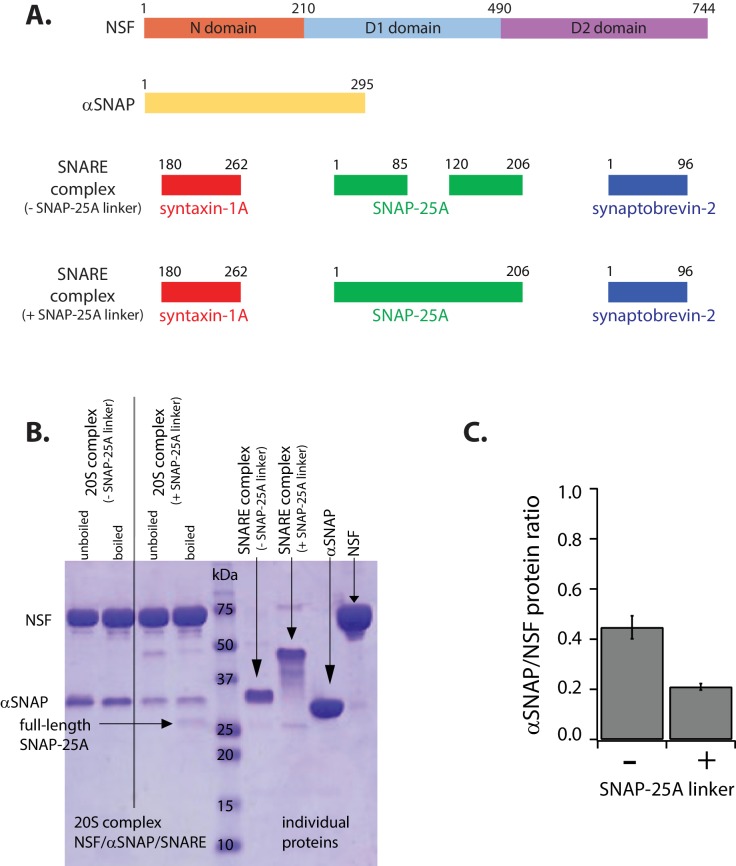
Protein quantification of the 20S complex using a gel-based assay.(A) Domain diagram of the 20S complex consisting of NSF (orange, light blue, pink), αSNAP (yellow), and the SNARE complex composed of the cytoplasmic domain of syntaxin-1A (red, amino acid range 180–262), two SNARE domains of SNAP-25A (green, amino acid range 1–85 and 120–206) or full-length SNAP-25A (green, amino acid range 1–206), and the cytoplasmic domain of synaptobrevin-2 (blue, amino acid range 1–96) (Materials and methods). (B) SDS-PAGE gel of the 20S complex formed in the absence and presence of the native linker of SNAP-25A that connects its two SNARE domains. (C) The intensities of the protein bands in the SDS-PAGE gel were quantified using ImageJ (Schneider et al., 2012). Shown are mean values ± SD for protein band intensities of αSNAP divided by the protein band intensities of NSF from two independent gels prepared by the same samples. The protein band intensities from the boiled samples were used since the molecular weight of the SNARE complex without the S25 linker was only slightly higher than that of αSNAP, interfering with densitometry. Additionally, all protein intensities were background-subtracted using the intensity of a nearby selected rectangular area.